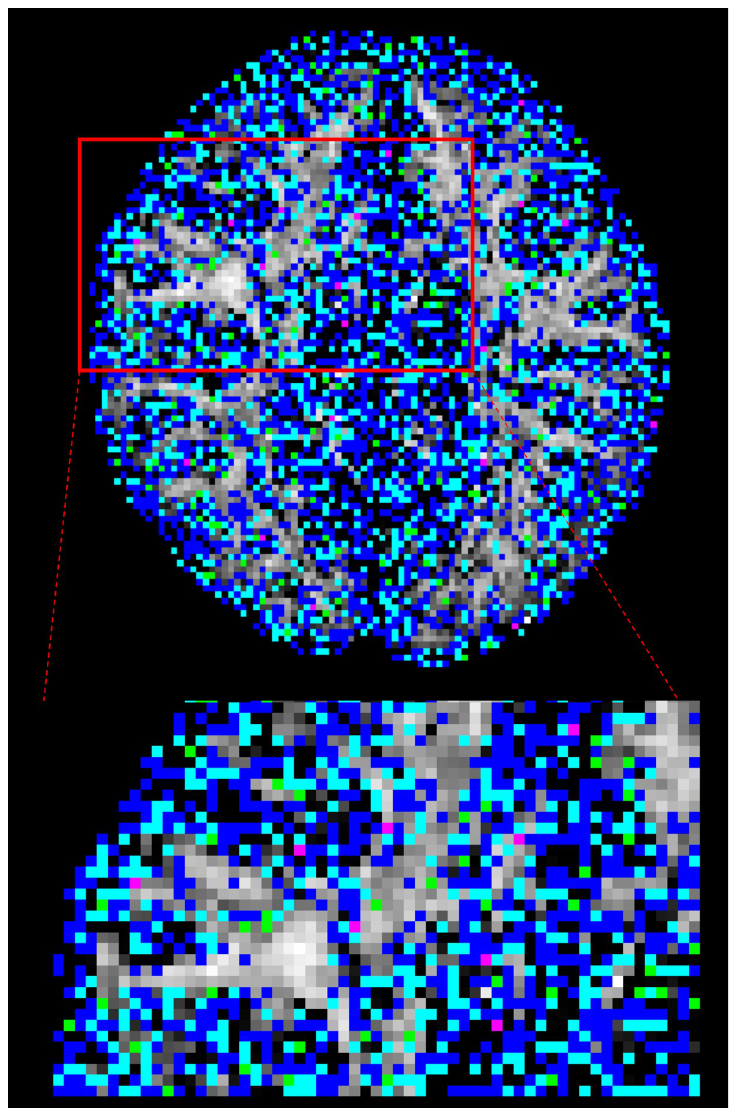
Fig 9. Significantly different ϕ 2 and θ 2 . Significantly different ϕ 2 and θ 2 distributions with S-ranges in 0.1–0.2 (Blue), 0.2–0.3 (light-blue), 0.3–0.4 (green), > 0.4 (magenta). Maximum S-score between ϕ 2 and θ 2 was used to categorize each location into different range (enlarged view from area in